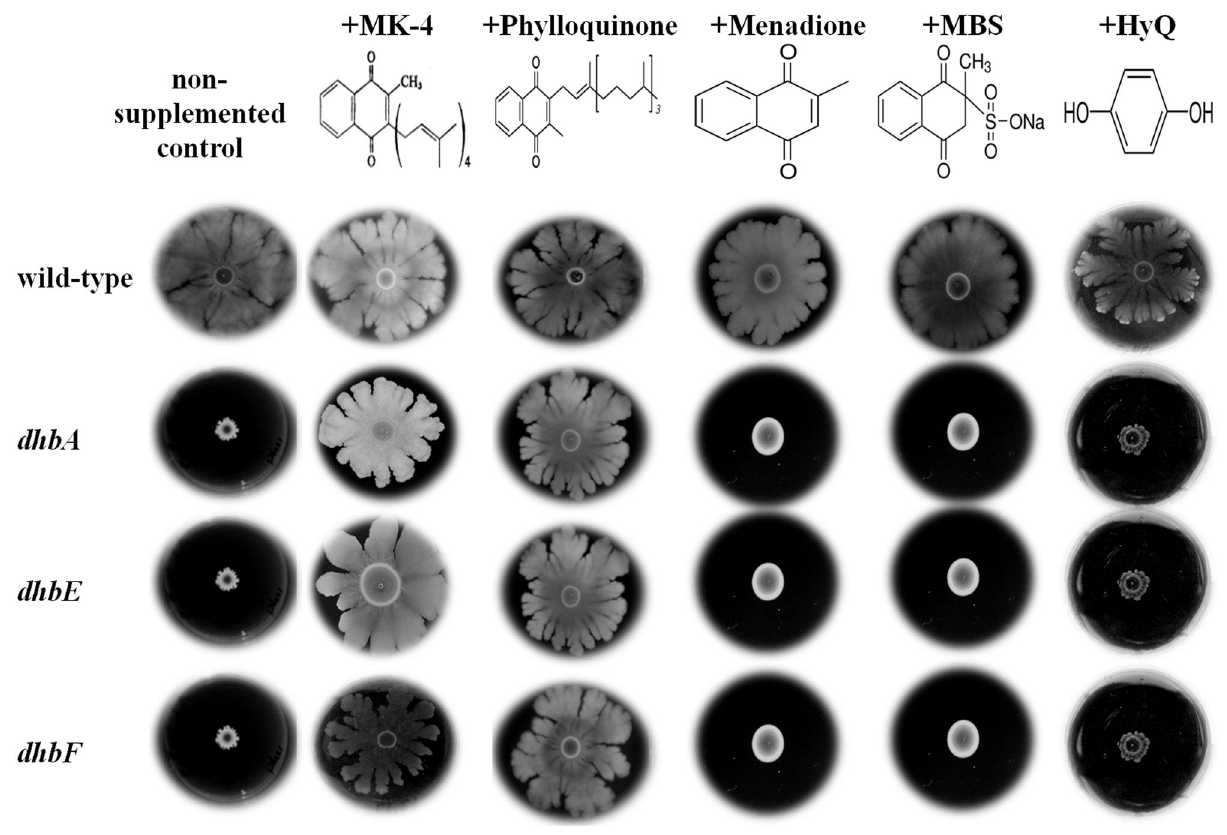
Figure 8. Menaquinone derivatives lacking an isoprenoid side chain cannot suppress the complex colony development defect in B. subtilis siderophore mutants. Three μl of a fresh overnight culture were spotted onto the center of spreading plates containing 1.2% agar, spreading plates containing 1.2% agar supplemented with 40 μg/ml of either MK-4, phylloquinone, menadione sodium bisulfite (MBS) or Hydroquinone (HyQ), or spreading plates containing 1.2% agar supplemented with 10 μg/ml of menadione. Photos were taken after 72 hours. Each experiment was carried out in